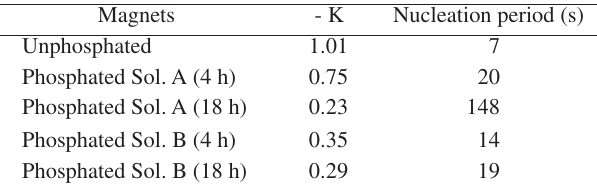
Table 1. K values and nucleation period obtained from experimental results fitted to Avrami’s equation for the various types of magnet surfaces that were